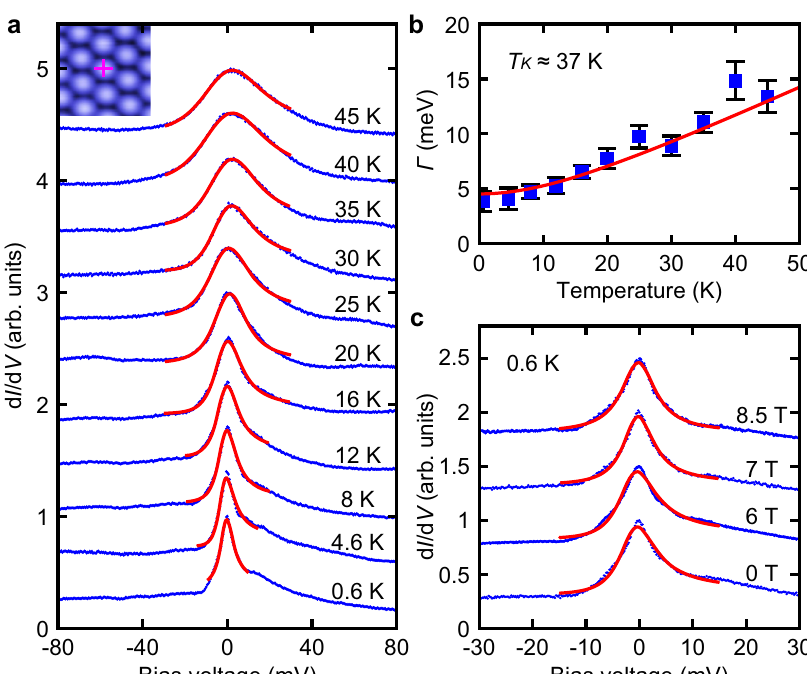
Fig. 3 Temperature and magnetic fi eld dependences of the ZBP. a The blue lines are the d I /d V spectra measured at different temperatures on the bright SD cluster of the Type-II 1 T -TaS 2 surface. The red lines are the thermally convolved Fano fi ts to the ZBP at each temperature. The purple cross in the inset shows the position for taking the temperature dependent d I /d V spectra. The spectra are vertically offset for clarity. b Evolution of the measured half width ( Γ ) at half maximum of the ZBP with temperature (blue squares with error bar). The error bars represent the uncertainty of the linewidths obtained from the thermally convolved Fano fi ts to the ZBP at each temperature. The solid red line is the best fi t to the function Kondo temperature of T K ≈ 37 ± 6 K. c The blue lines are the d I /d V spectra measured with different external magnetic fi elds at 0.6 K. The red lines are the thermally convolved Fano fi ts to the ZBP at the measured magnetic fi elds. The spectra are vertically offset for clarity. Source data are provided as a Source Data fi